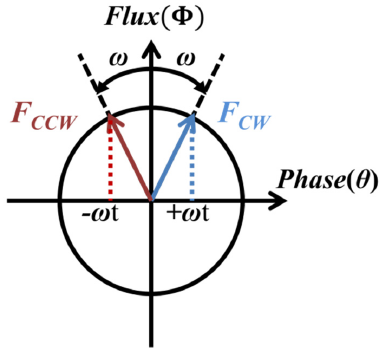
Figure 3. Magnetic motive force distribution in SPIM.